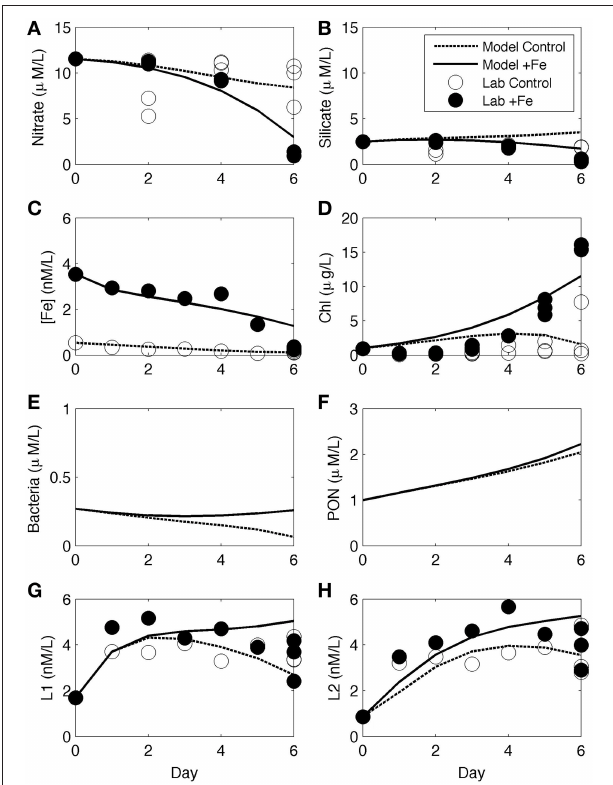
FIGURE 6 | Numerical modeling results from incubation experiment 1. Results for nitrate (A), silicate (B), [dFe] (C), chl a (D), bacteria abundance (E), PON (F), L 1 (G), and L 2 (H) are shown from the model of the controls (dashed line) and + Fe treatments (dark line), along with the data from controls (open circles) and + Fe treatments (closed